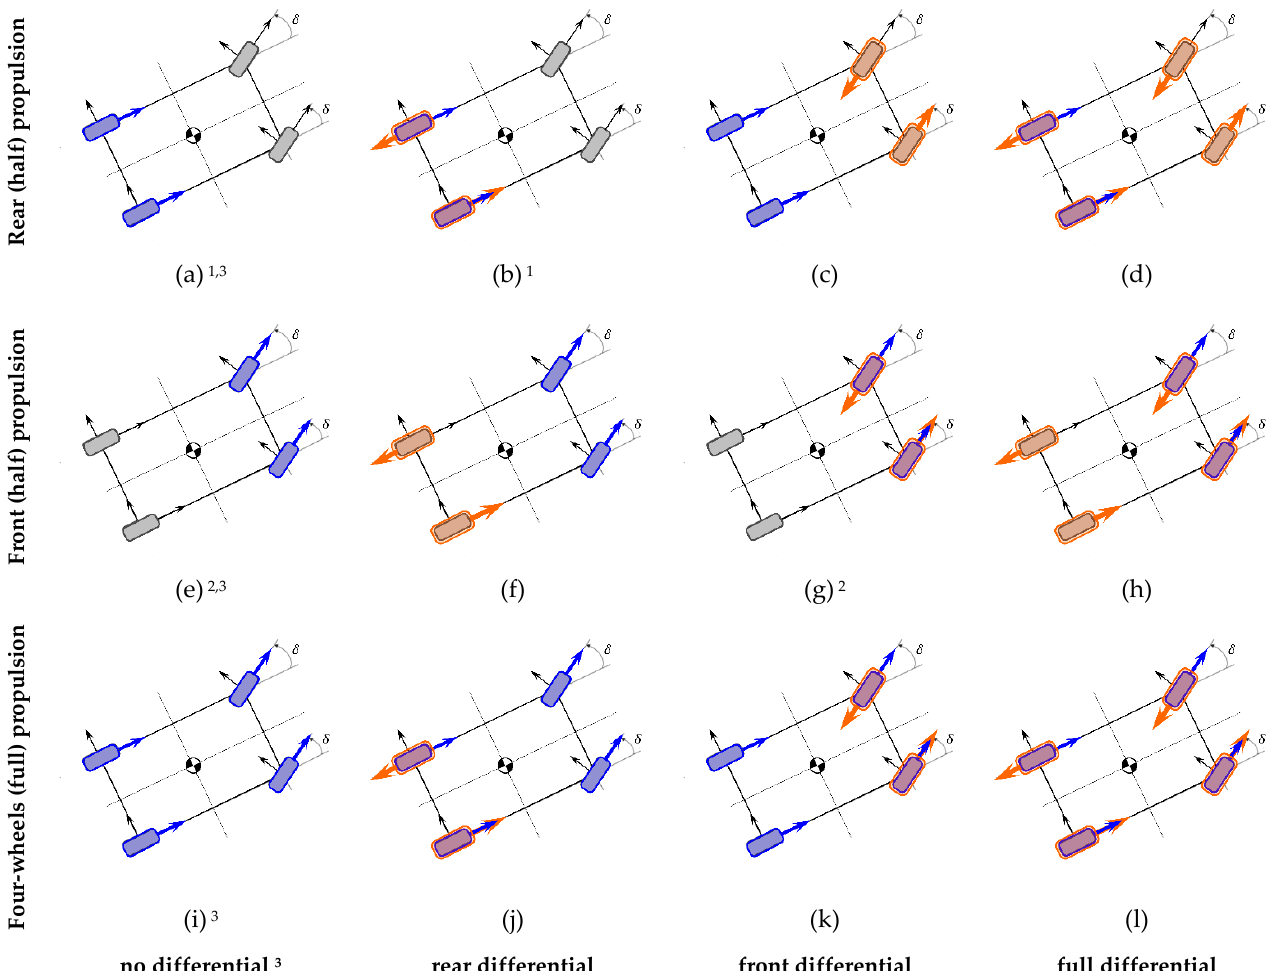
Figure 6. Soft configuration: Driving Mode Selection. ( a – d ) Rear (half) propulsion; ( e – h ) Front (half) propulsion; ( i – l ) Four- wheels (full) propulsion. 1,2,3 (See Table 1): 1 2WD “hard” configuration → s ( f ) = ( 1,1,0,0 ) ; 3 differential ON/OFF command d D ≡